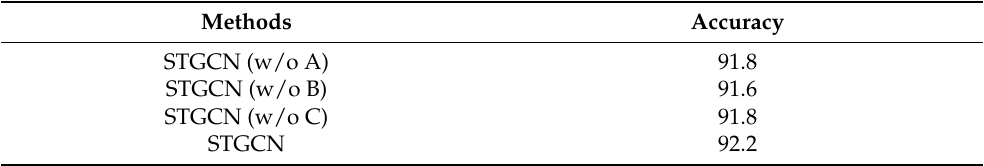
Table 1. Comparison of the validation with the X-view accuracy of STGCN with or without differ- ent